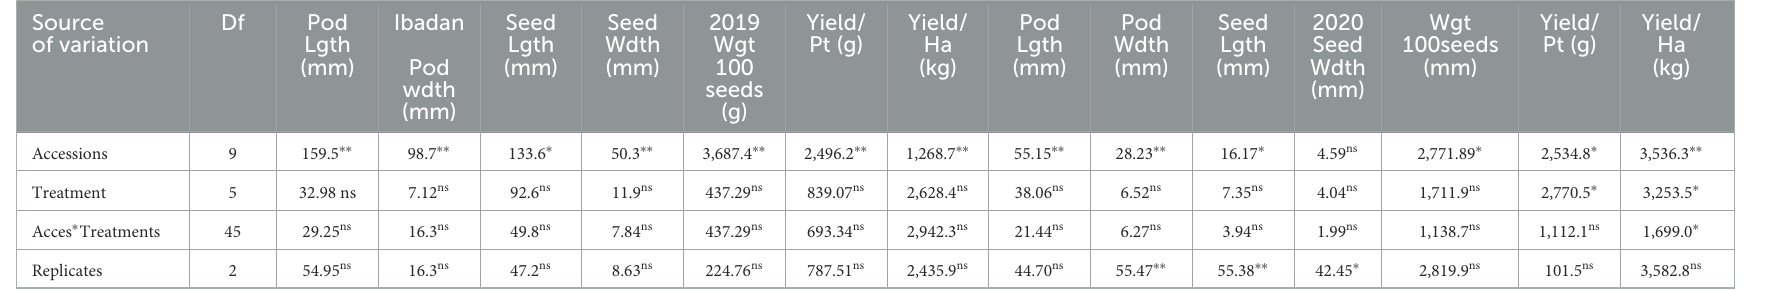
TABLE 4 Analysis of variance showing the effect of treatments on yield and yield components of BGN accessions in Ibadan, 2019 and 2020. Source of variation